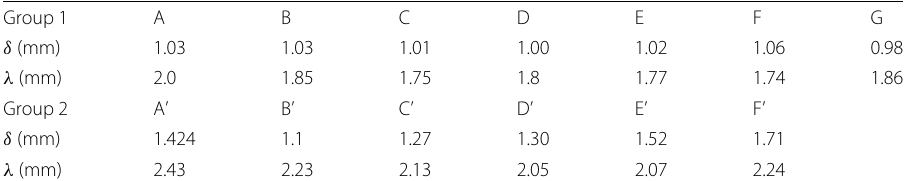
Table 2 The boundary layer thickness δ and the wavelength λ of high-frequency p w at probe points in Group 1 (upstream of the transition front) and in Group 2 (downstream of the transition front) Group 1 A B C D E F G δ (mm) 1.03 1.03 1.01 1.00 1.02 1.06 0.98 λ (mm) 2.0 1.85 1.75 Group 2 A’ B’ λ (mm) 2.24